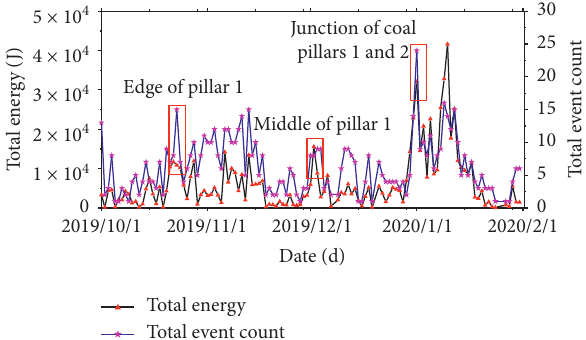
Figure 11: Varying curve of total energy and event counts of MS with face under